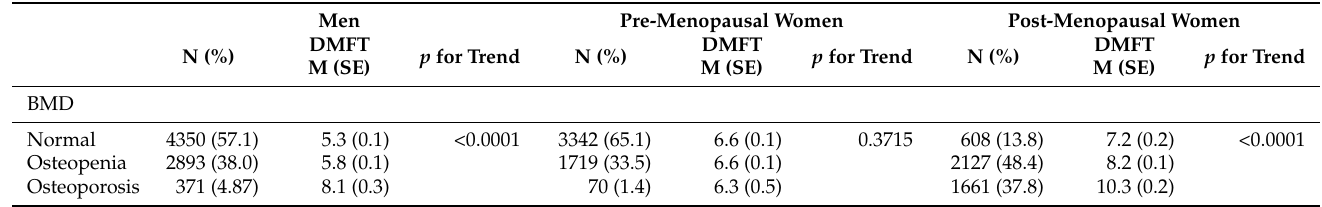
Table 2. Comparison of DMFT index on bone mineral density by sex and menopausal